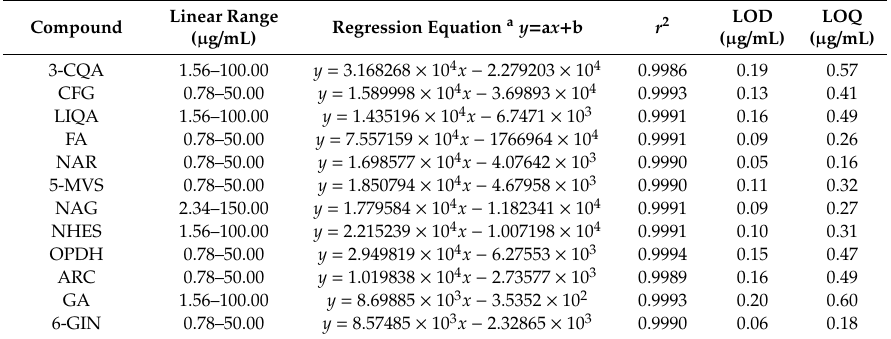
Table 1. Linear range, regression equation, r 2 , LODs, and LOQs for marker compounds using HPLC– PDA ( n = 3).